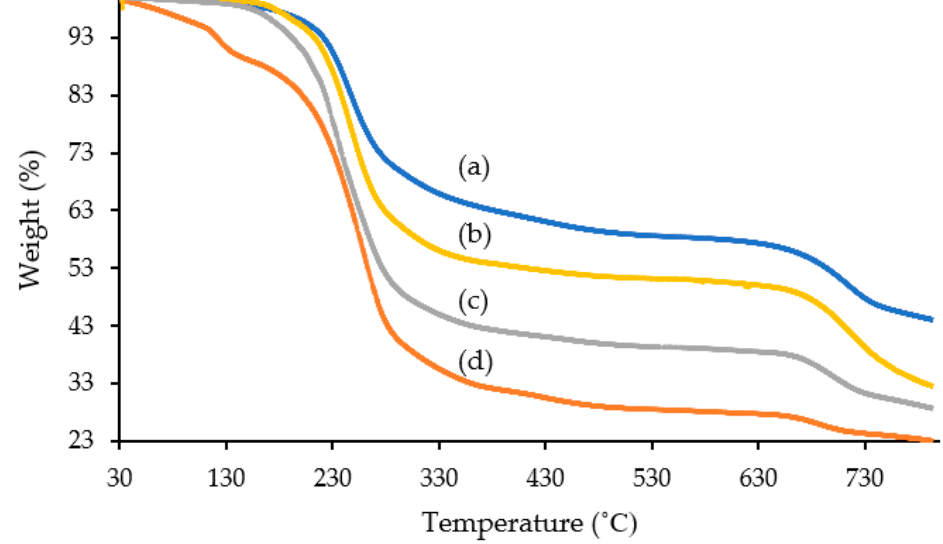
Figure Figure 3. Thermal gravimetric analysis study of synthesized lignosulfonate-based ILs. (a)